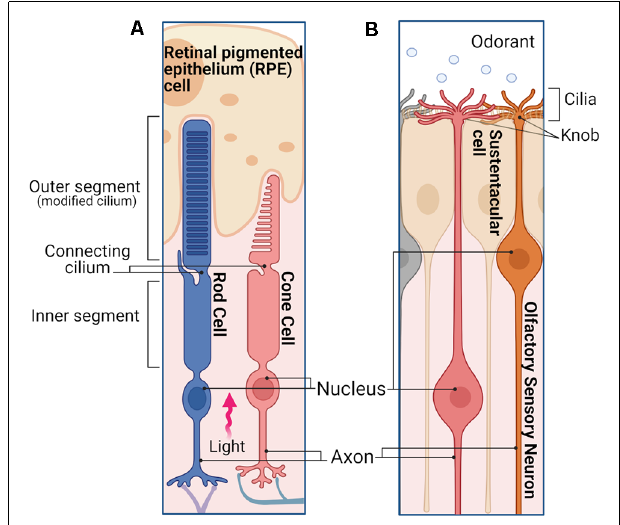
FIGURE 1 | Photoreceptors and olfactory sensory neurons (OSNs). (A) Simplified schematic representation of a rod and a cone in the retina. Photoreceptors are polarized neurons with a specialized morphology optimized to detect light stimuli. The outer segments of both rods and cones are modified sensory cilia, containing membrane disks organized in a stack. In the case of rods, the outer segment has a slim rod-like structure in which the disks are enclosed by the plasma membrane. The outer segment of the cones has a stocky conical-shaped structure, in which the disks are constituted by invaginations of the plasma membrane. The outer segment does not contain any proteins of the cell translation machinery, which are mostly localized in the inner segment, including the endoplasmic reticulum, Golgi, and mitochondria. Outer and inner segments are connected by the connecting cilium, while distal to the inner segment is the cell body containing the nucleus, followed by the axon and synaptic termini that extend into the outer plexiform layer where they synapse with the second order neurons. When the light enters the eye, after reaching the retina, it travels along the length of the rod and cone inner segment until finally reaching the outer segments. (B) Simplified schematic of an OSNs in the olfactory epithelium. OSNs are ciliated bipolar neurons, their apical dendrites extend to the surface of the epithelium terminating with a spherical structure called dendritic knob, from which the sensory cilia enter the mucus layer. The ciliary membrane contains the olfactory receptors (ORs) necessary to detect different odorants. Distal from the knob is the cell body of the OSN with its nucleus, followed by a long axon that projects to the olfactory bulb, where it synapses with the second order neurons. Images created with